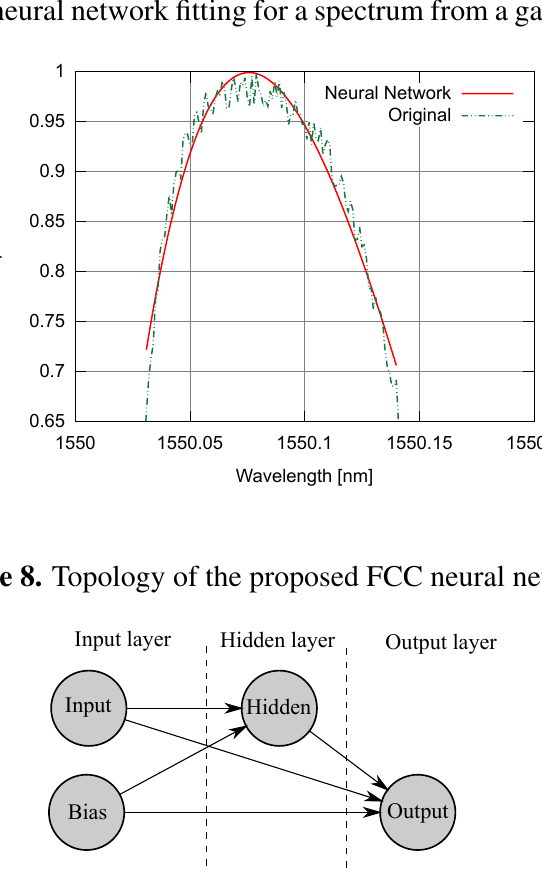
Figure 7. Example of neural network fitting for a spectrum from a gaussian modulated FBG.